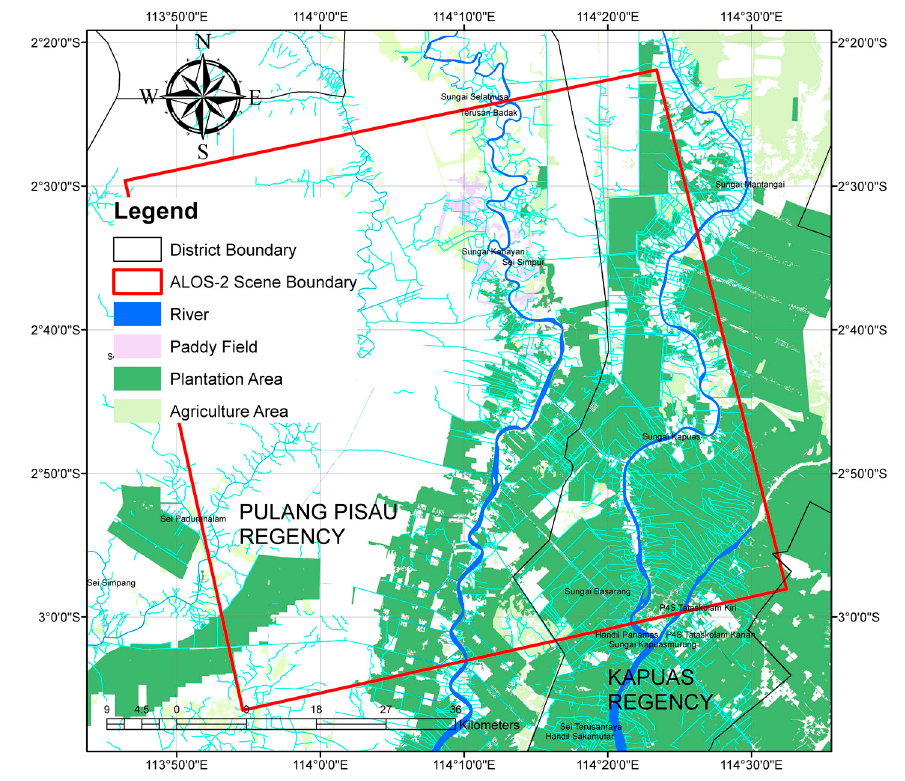
Figure 5. Landcover of this research area.